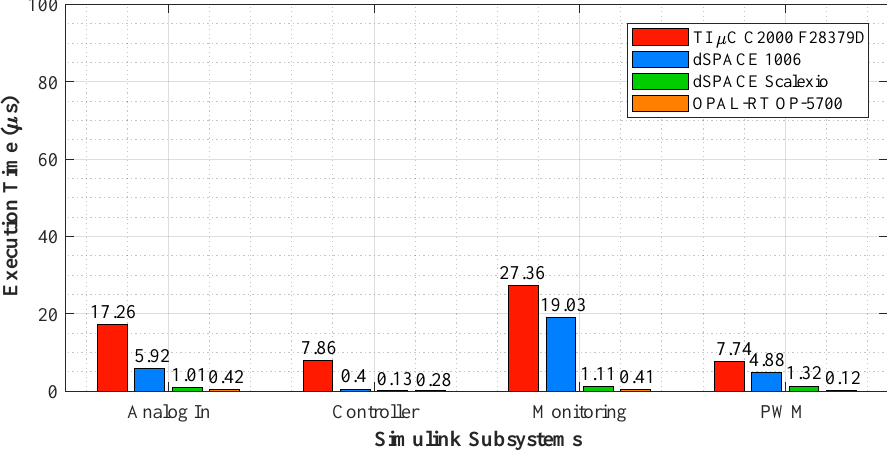
Figure 15. Computation time profiles for the PI ( dq ) controller of the debugged